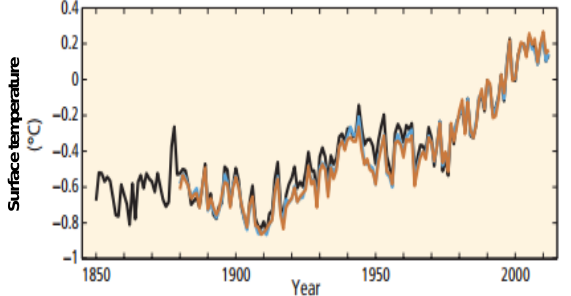
Figure 9. Globally averaged combined land and ocean surface temperature anomaly, modified from [29].